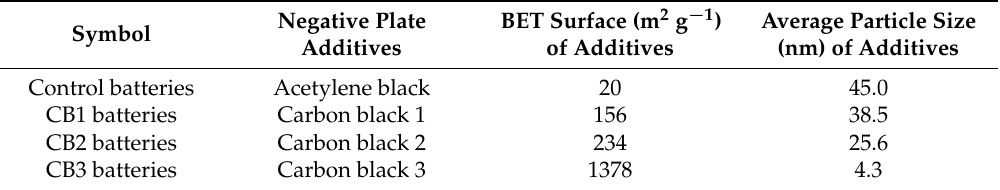
Table 1. Characteristics of the carbon black additives used in this work. BET = Brunauer–Emmett– Teller